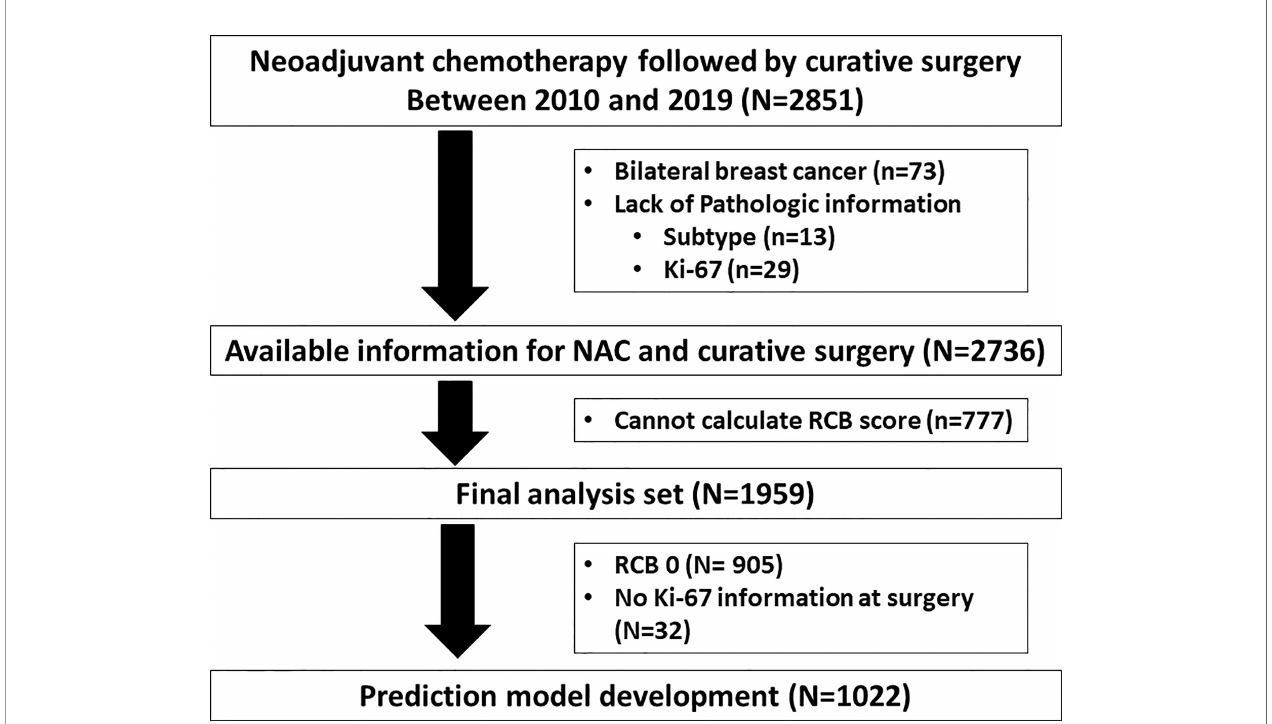
FIGURE 1 | Consort